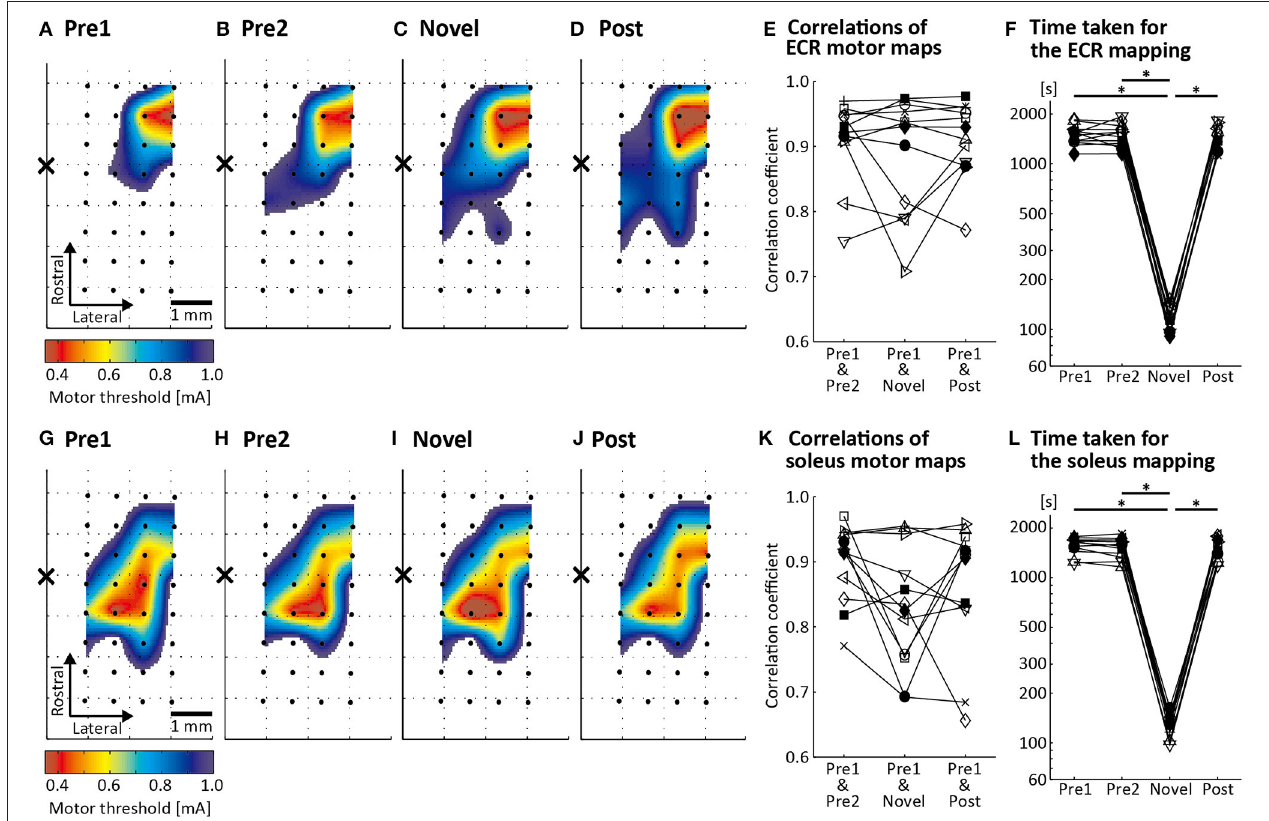
FIGURE 3 | Results of motor mapping by cortical surface stimulation (CSS). Topographical spatially interpolated ECR (A–D) and soleus (G–J) motor maps from one representative rat. The color scale reflects the MT. Black dots and the cross in each panel indicate the location of the 32 stimulating electrodes and of the bregma, respectively. Motor maps of Pre1, Pre2, and Post conditions were assessed using the conventional CSS mapping procedure (conventional MT criterion and stimulus frequency of 1Hz). Motor map of the Novel condition was assessed using the novel CSS mapping procedure (newly proposed MT criterion and stimuli repeated at 4Hz). (E,K) Spearman’s correlation coefficient calculated for three different pairs of motor maps in 12 rats: between the Pre1 and Pre2 conditions, between the Pre1 and Novel conditions and between the Pre1 and Post conditions. (F,L) Time taken for the mapping procedure in the 12 animals in the four conditions. Each line represents one animal. * p <